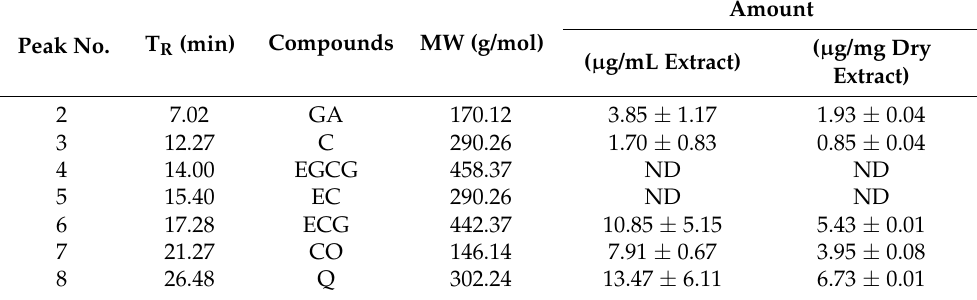
Table 2. HPLC-DAD analysis of the phenolic content in 50% ethanolic extracts of P. odoratum Lour. cv. Pakphai leaves. Data obtained from two separate experiments are expressed as mean ± standard errors of mean (SEM) values.